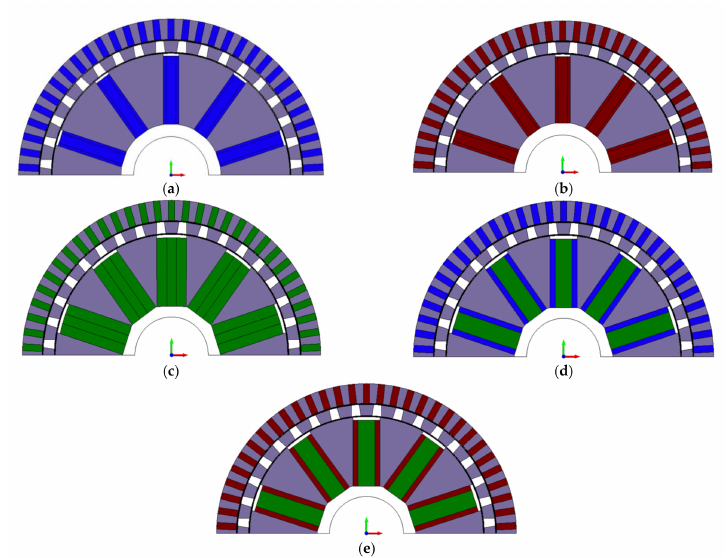
Figure 5. Repetitive finite element (FE) models of various FM-CMG designs ( a ) Dy-NdFeB Design, ( b ) Dy-free NdFeB Design, ( c ) Ferite Design, ( d ) Dy-NdFeB with Ferrite Design, and ( e ) Dy-free NdFeB with Ferrite Design.